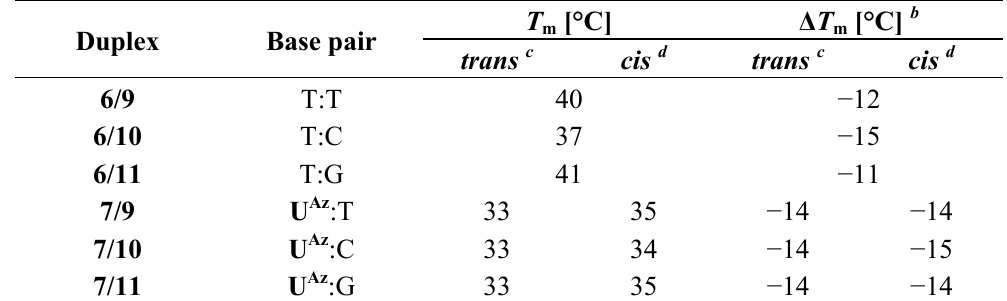
Table 3. UV-melting points of DNA duplexes with a mismatched base pair.